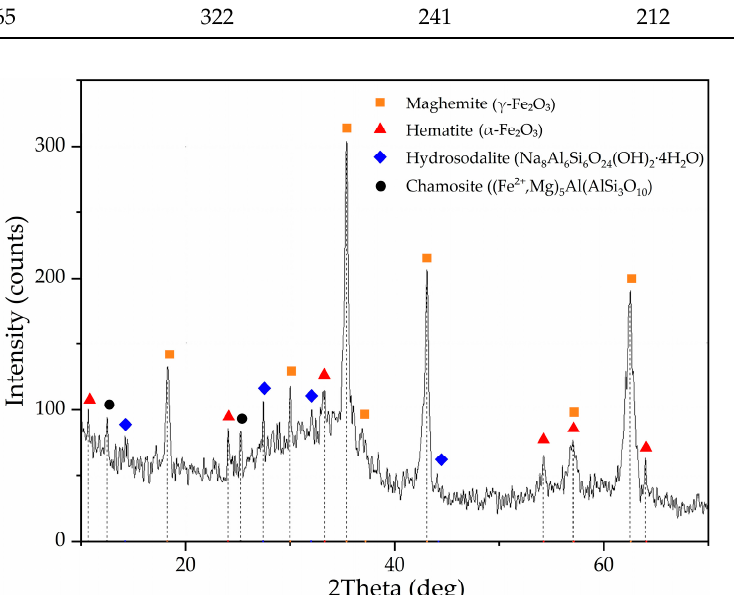
Figure 1. XRD pattern of the initial red mud obtained by alkali fusion-leaching of bauxite (RMF).